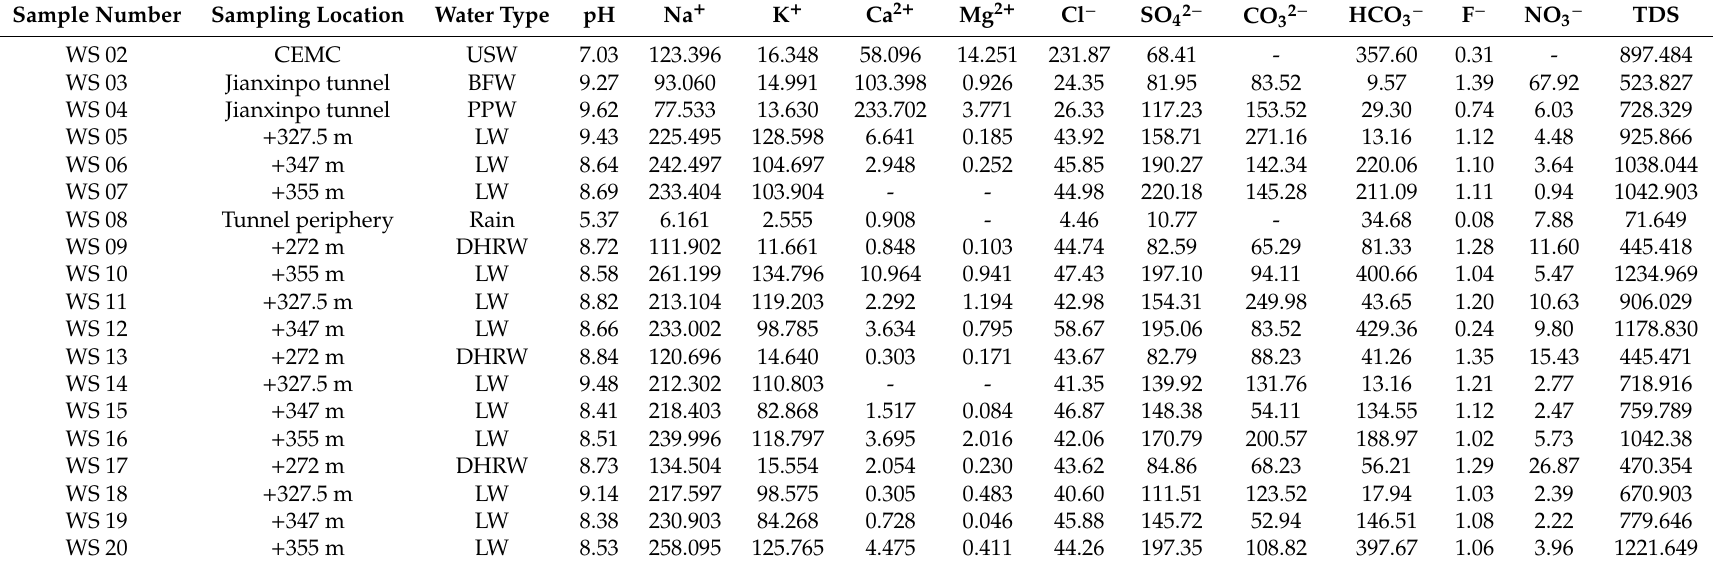
Table 1. Chemical analyses of water samples (unit: mg / L except